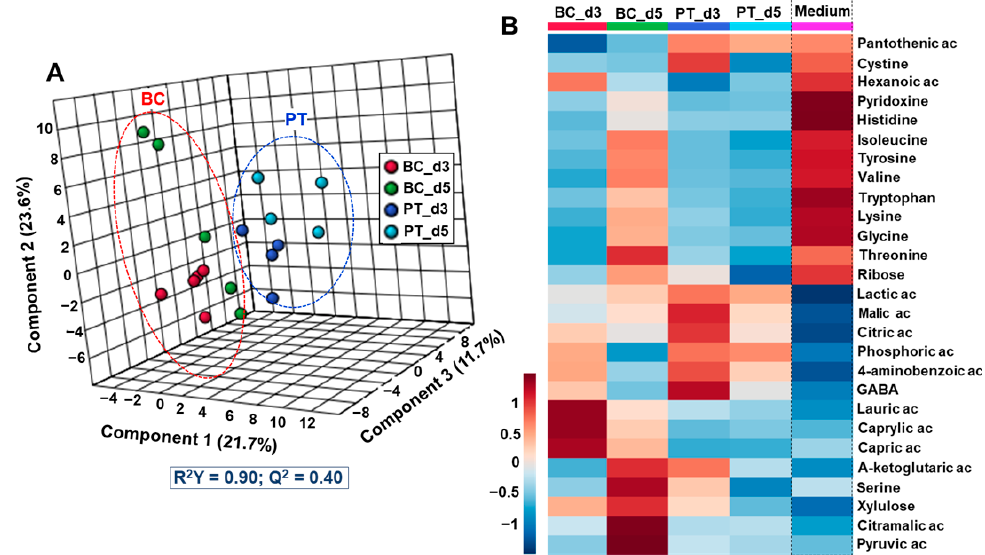
Figure 3. Global multivariate statistical analysis of Petri and biochip metabolomic profiles on Day 3 and 5. ( A ) PLS-DA scores plot discriminating Petri and biochip cultures; ( B ) heatmap of 27 metabolites significantly modulated. PLS-DA: partial least squares-discriminant analysis; BC_d3 and BC_d5: biochip cultures after 3 and 5 days; PT_d3 and PT_d5: Petri cultures after 3 and 5 days.